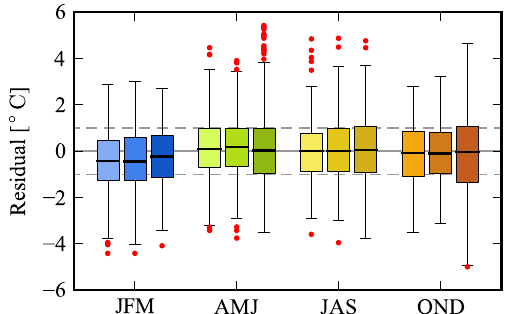
Figure 3. Prediction error of the physics-inspired statistical model for different resolutions of the stream network. The boxes extend from the first to the third quartile of the error distribution. Outliers are displayed as red dots. In each season, the network resolution decreases from left to right: the left box corresponds to the network with all stream reaches, whereas the central and right boxes contain only the stream segments whose Strahler order is greater than or equal to 2 and 3, respectively. The error values 0, − 1 and + 1 ◦ C are displayed as a solid grey line and two dashed grey lines.